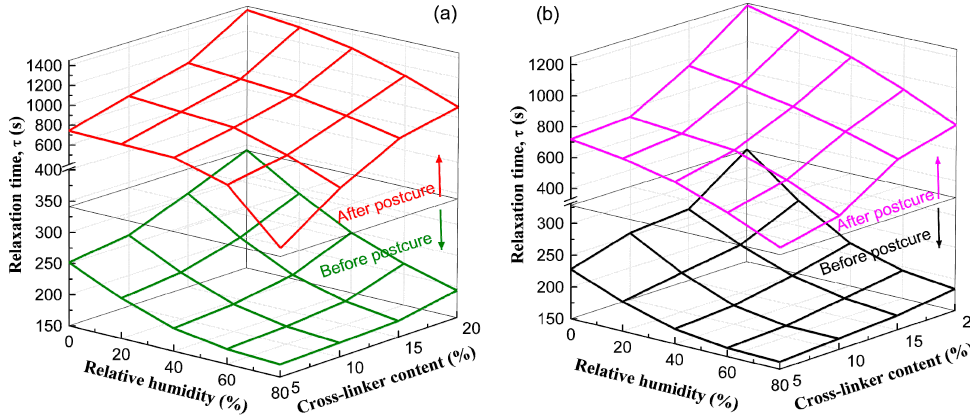
Figure 12. Changes in relaxation time against different RH and crosslinker content for ( a ) xPVAc/EMDI and ( b ) xPVAc/p-MDI films before and after post-curing treatment.